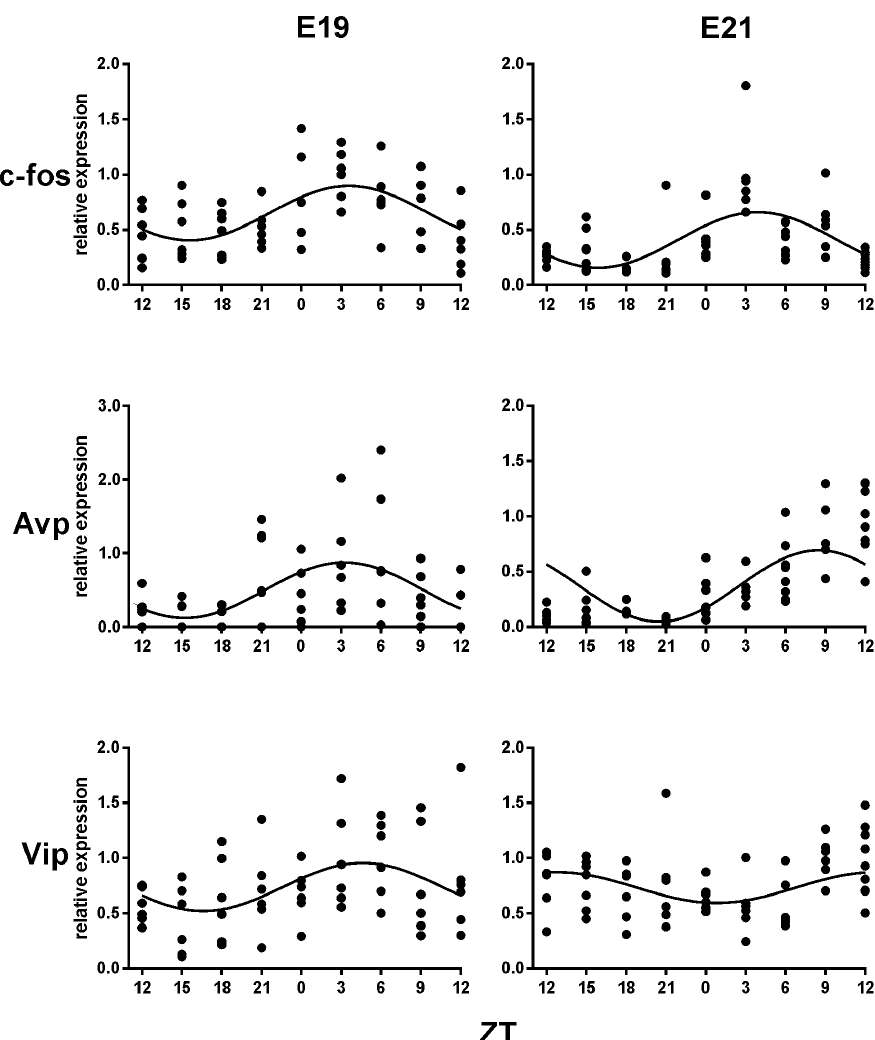
Figure 3. The gene expression profiles in the fetal rat SCN. The 24-h profiles of c-fos , Avp and Vip were detected at E19 (left column) and E21 (right column). For further details, see legend to Figure 2. doi:10.1371/journal.pone.0107360.g003 maximal expression levels between E19 and E21 (P =0.017 and For c-fos (Fig. 4D), the minimal and maximal expression levels P , 0.001, respectively). were significantly different at E19 (ZT12 vs. ZT3; P= 0.018) and Table 2. Cosinor analysis of c-fos , Avp and Vip gene expression profiles in the SCN of fetuses at E19 and E21.